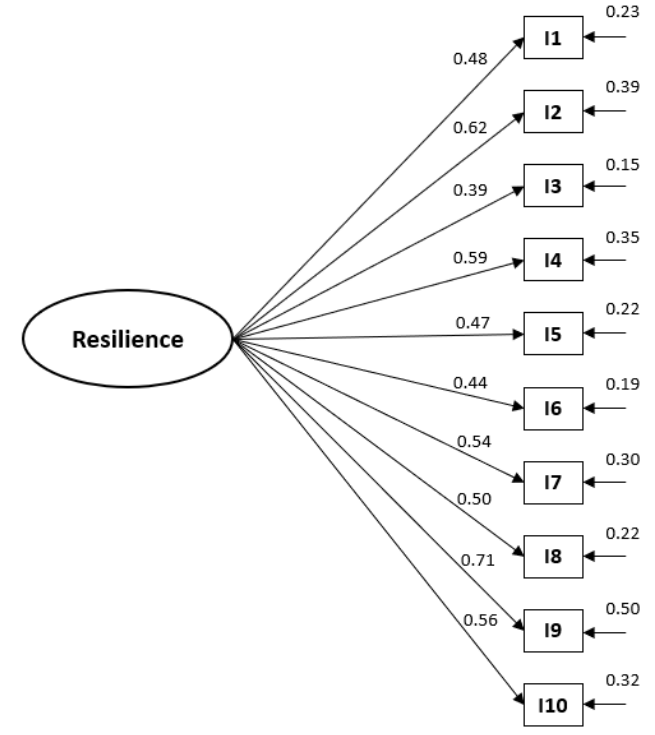
Figure 1. CD-RISC 10© model with standardized parameter values.